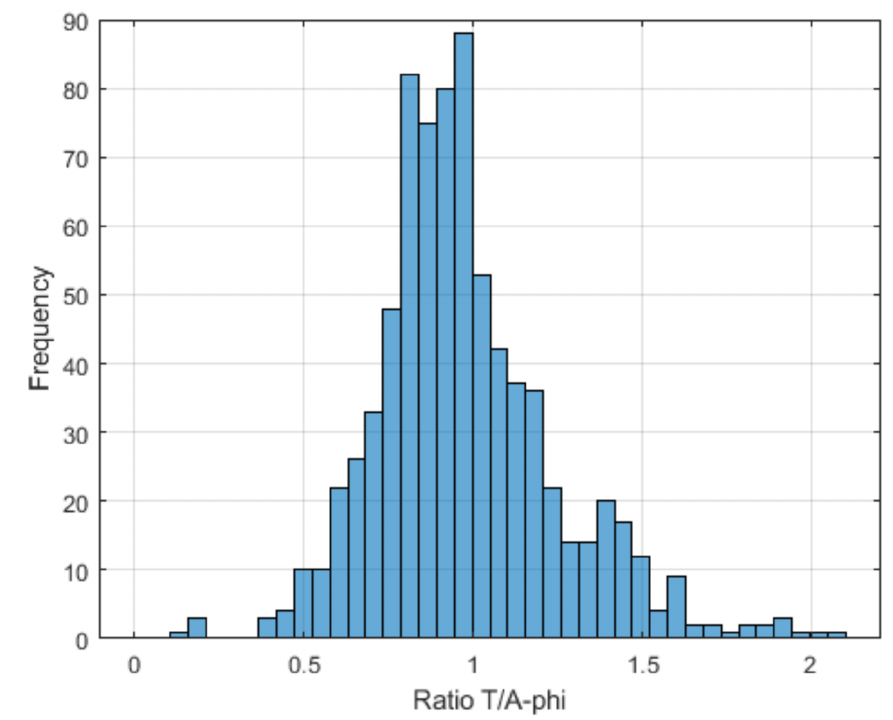
Figure 5. Frequency distribution of entire set of ratios between maximum E-field values (after filtering) obtained with T solver (E_out T ) with respect to the A - φ solver (E_out A- φ ), computed for each